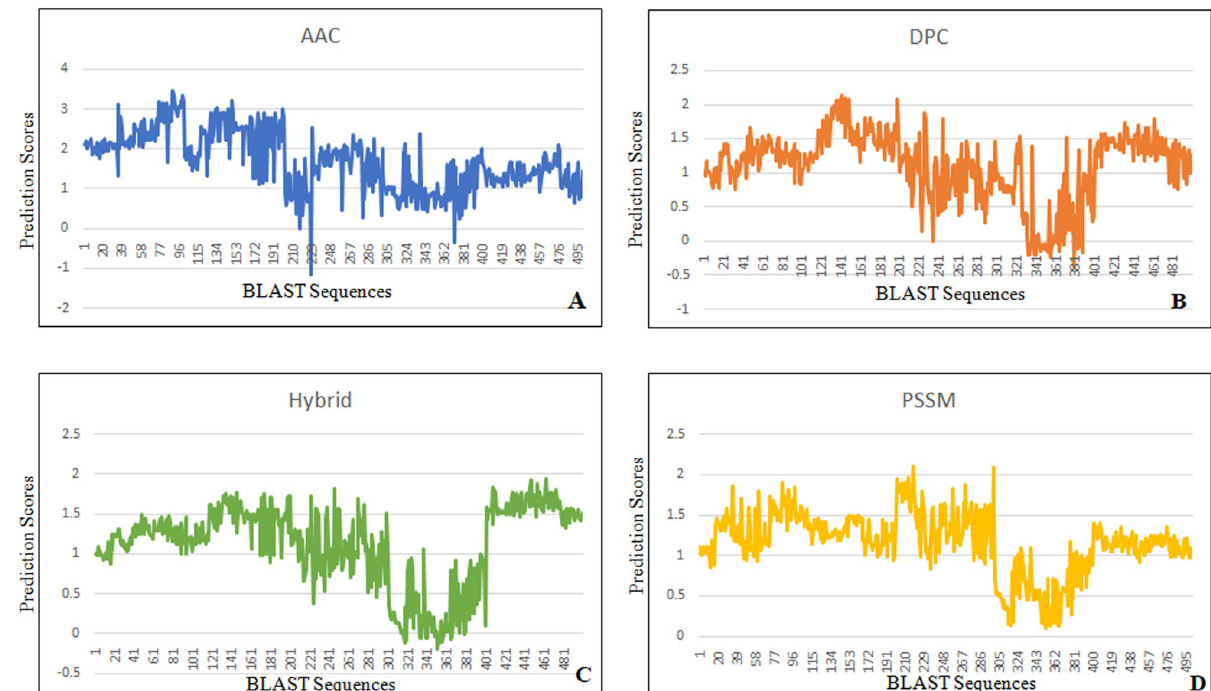
Fig 5. BLAST-Search Data analysis: Prediction performance of all models on the BLAST-Search data, A) AAC, B) DPC, C) Hybrid and D) PSSM.